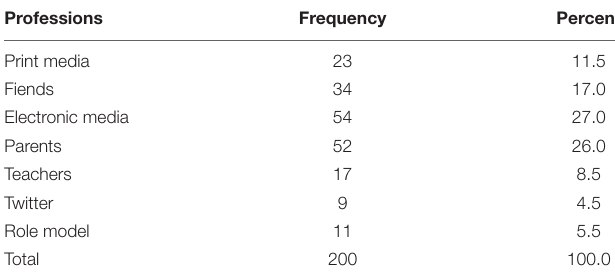
TABLE 2 | Source of career information ( N = 200).